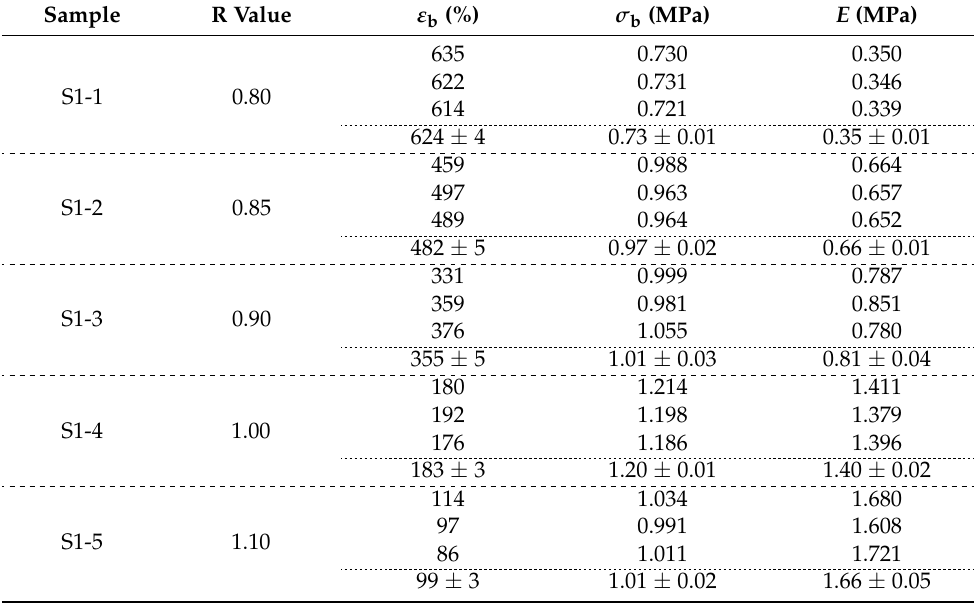
Table 6. Mechanical properties of aged elastomers with different R